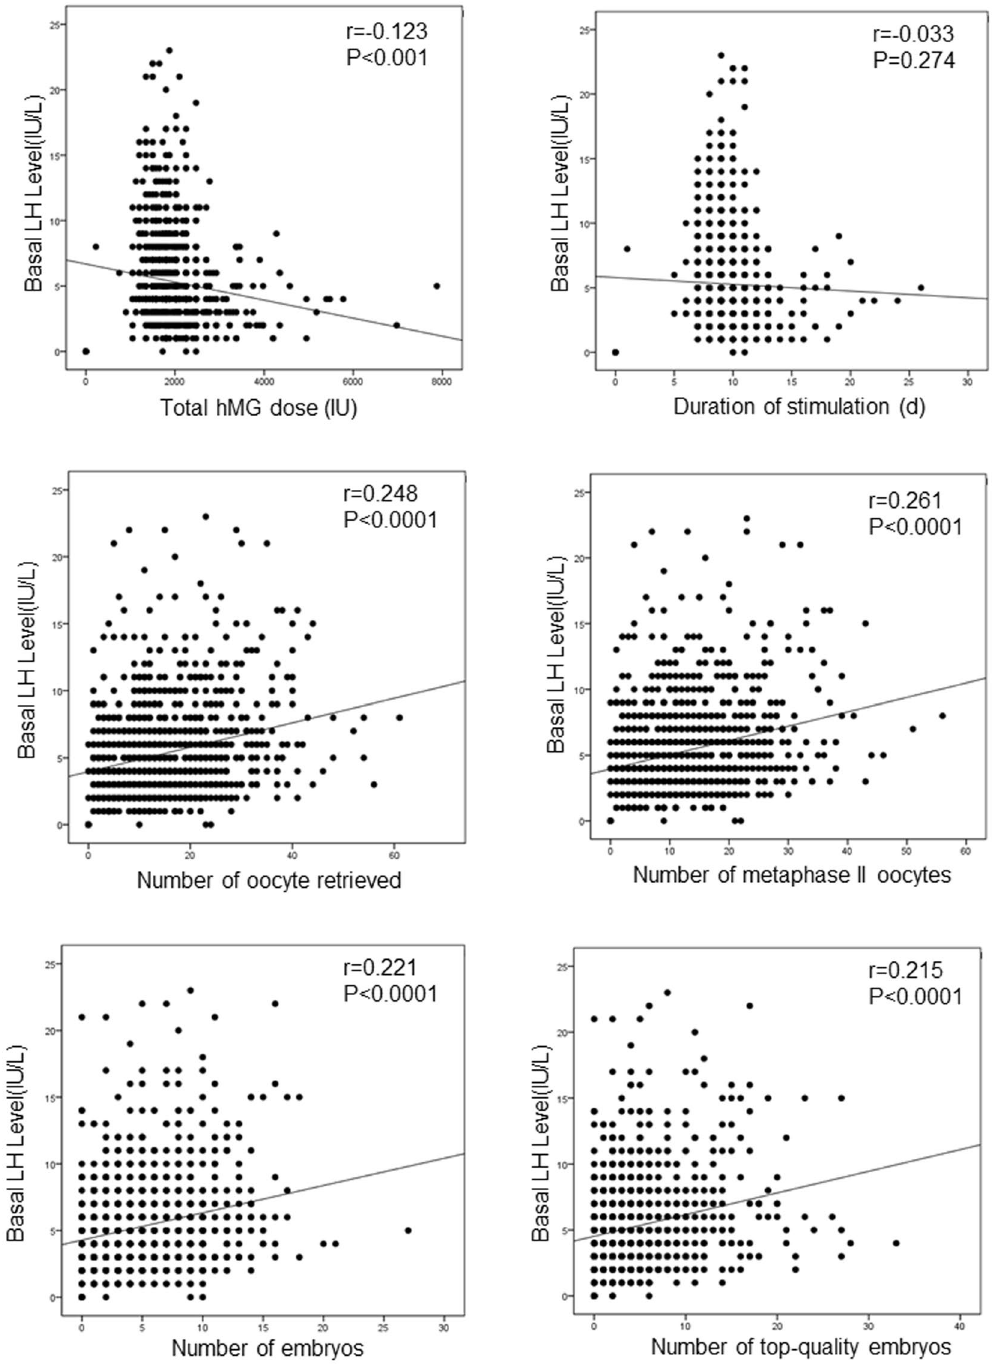
Figure 2. Correlation of basal LH level with total hMG used, days of ovarian stimulation, number of oocytes retrieved, number of metaphase II oocytes, number of embryos, and number of top-quality